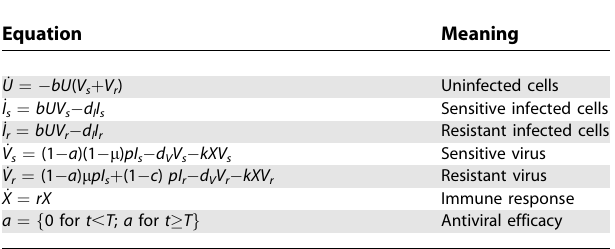
Table 1. Equations for the Two Models Describing the within- Host